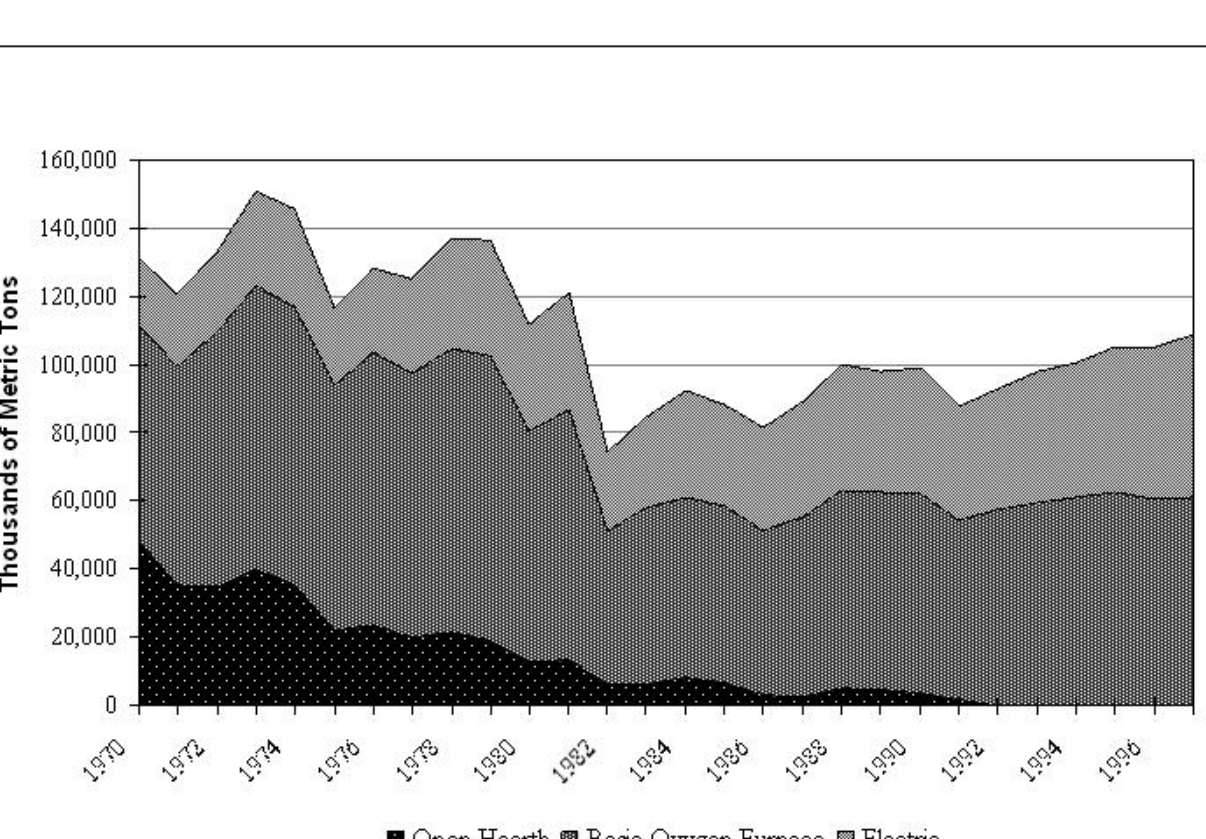
Fig. 4. Steel output by type of production technology, U.S.